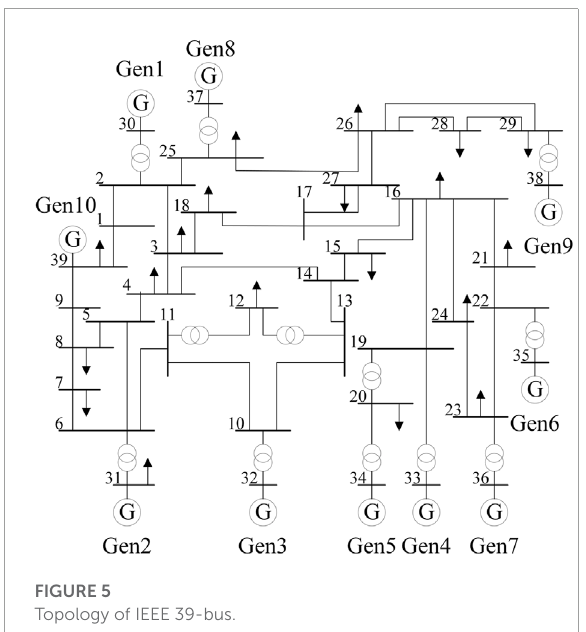
FIGURE 5 Topology of IEEE